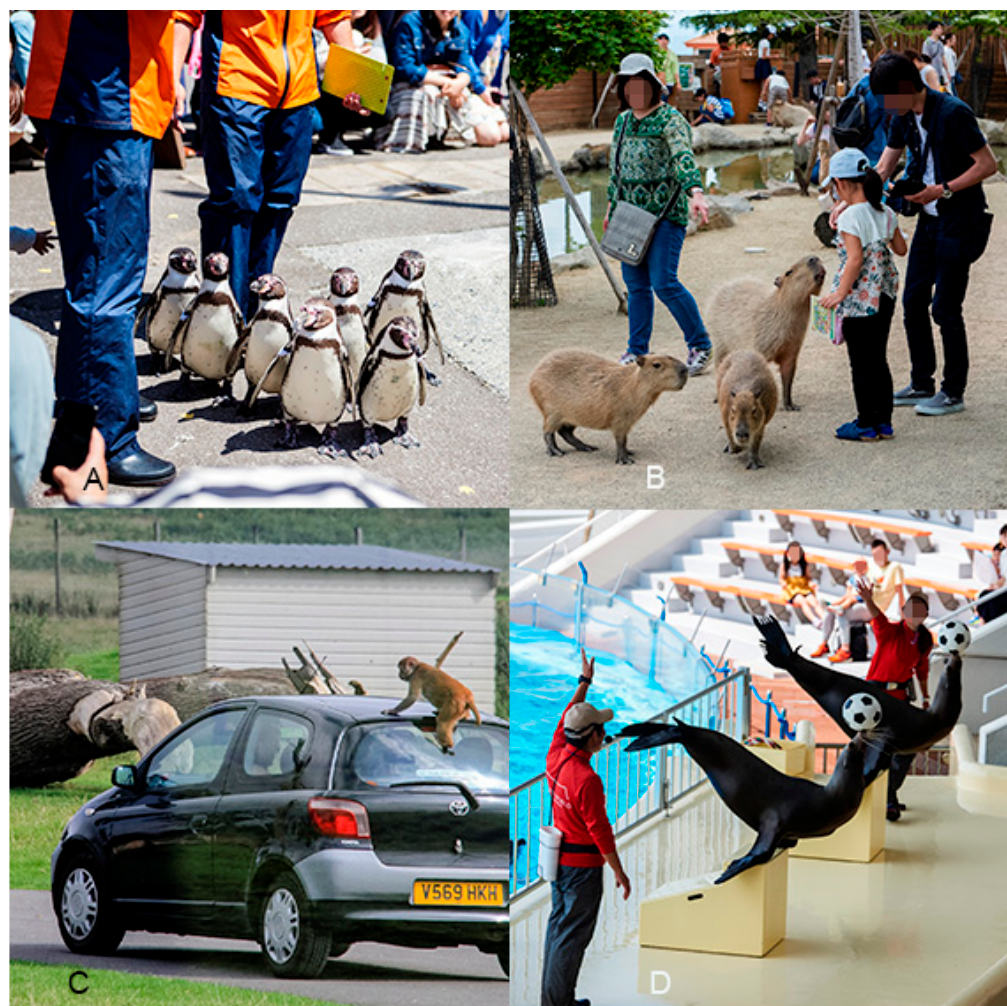
Figure 3. Example images for four different AVI types described in this study: ( A ) Walking with an African penguin ( Spheniscus demersus ); ( B ) Walking through a capybara enclosure ( Hydrochoerus hydrochaeris ); ( C ) Driving through a macaque enclosure ( Macaca sp . ); ( D ) Show and performance with sea lions ( Zalophus californianus ). Images were taken from screenshots of our data set included in this study. Images A, B and D were taken by a field researcher during visits to facilities (copyright Fernando Carniel Machado); image C was obtained via Flickr (copyright Karen Roe (CC BY-SA 2.0)). All images were taken at facilities that fall under the category of belonging to WAZA regional association members, they have been altered to ensure any individuals are made anonymous and are representative of screen shots included in the data set of this study.